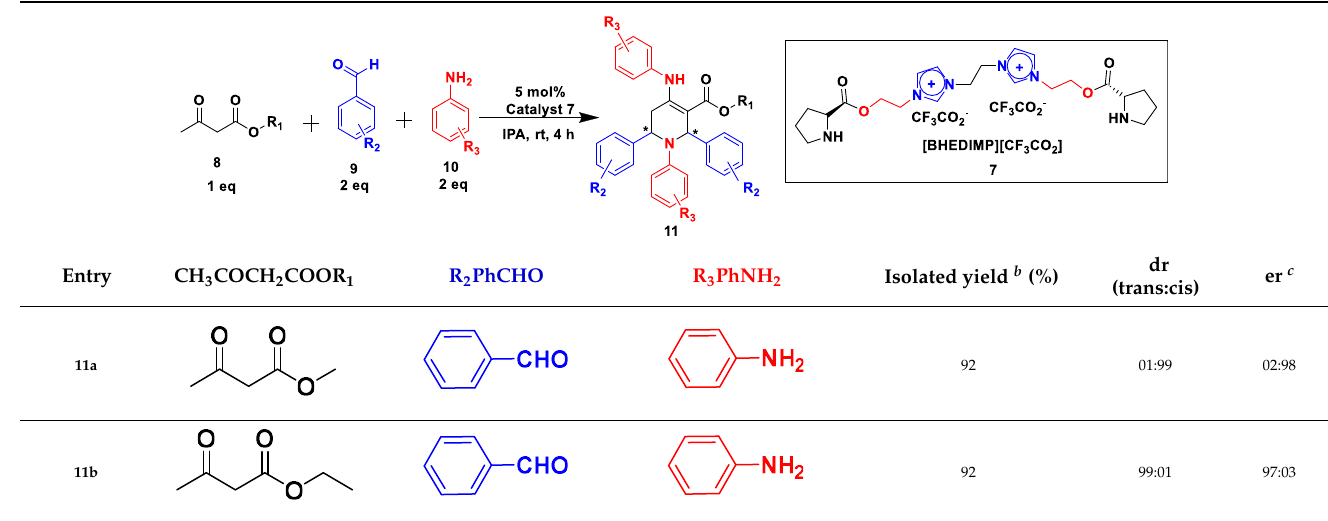
Table 3. Substrate scope for several THP derivatives 11a–o a .